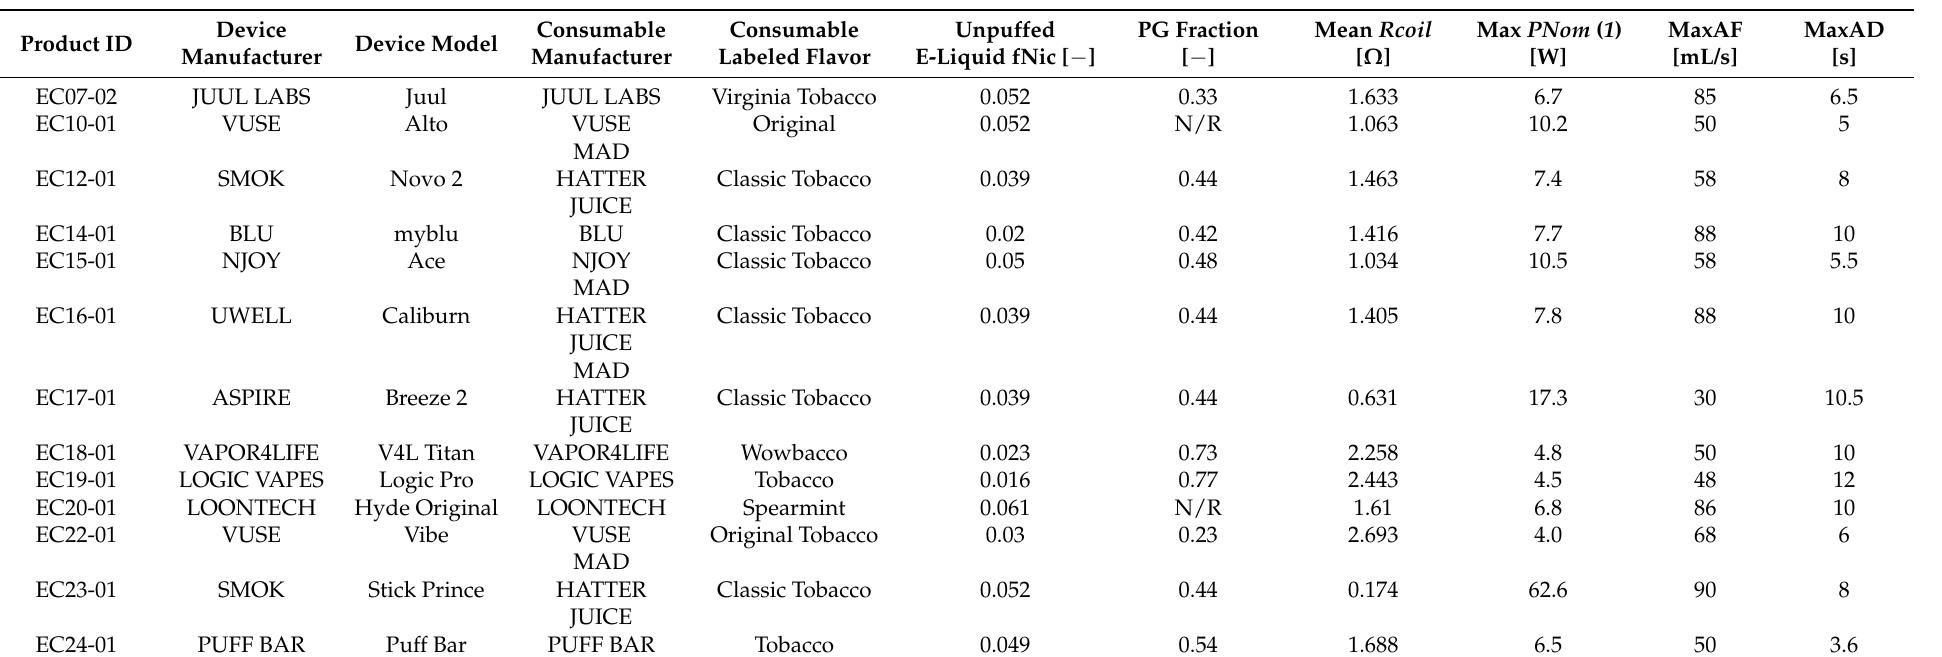
Table 2. Product design characteristics describing the 13 ENDS PCUS and corresponding consumable used for this investigation. Adapted from underlying data reported in